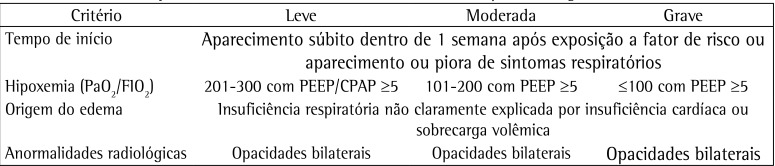
Classificação de Berlim da sindrome de desconforto respiratório
agudo(173) PaO2/FiO2 - relação entre pressão parcial de oxigênio e fração
inspirada de oxigênio; PEEP - pressão expiratória final positiva; CPAP -
pressão positiva contínua nas vias aéreas.